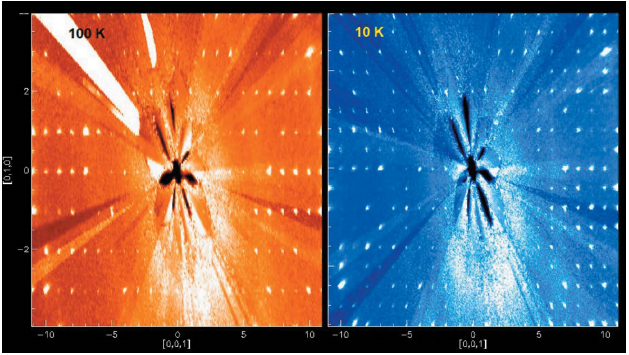
Figure 3 Comparison of reciprocal-space plots of the (0 kl ) plane at 100 K (left, red) and 10 K (right, blue), showing additional horizontal lines of reflections at 10 K, corresponding to a doubling of the b cell axis.